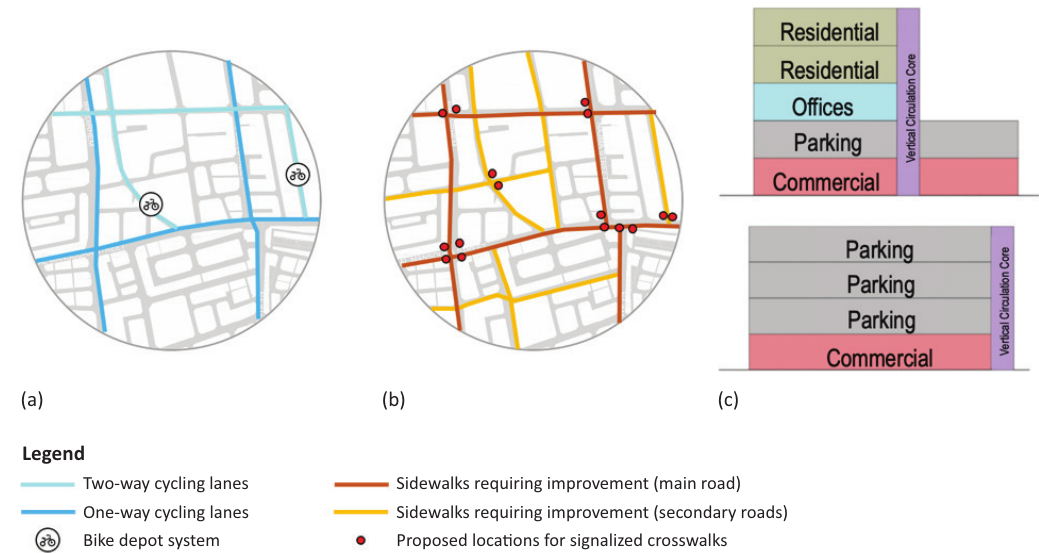
Figure 12. Transportation ideas: (a) Proposed cycling networks, (b) proposed pedestrian pathways, and (c) proposed park‐ ing